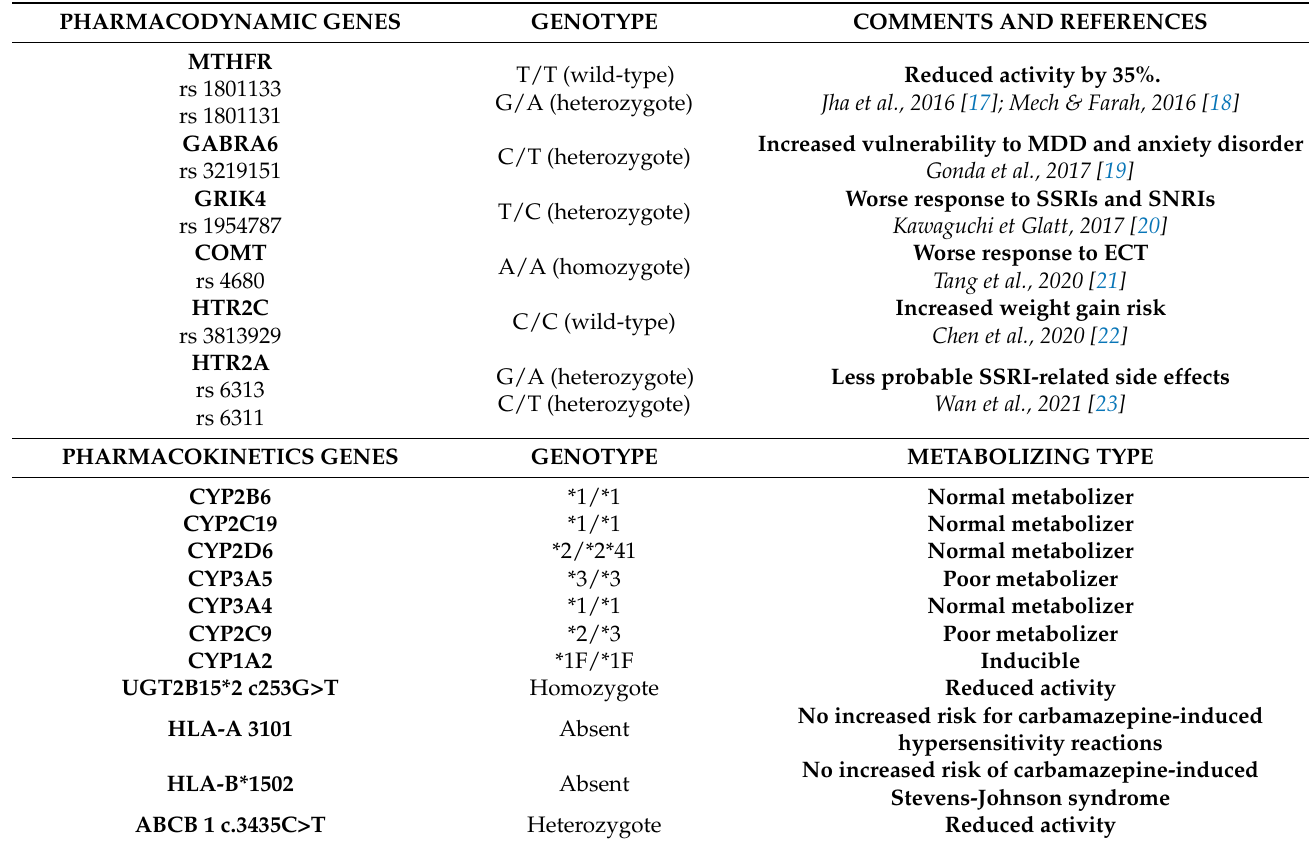
Table 7. Pharmacogenetic